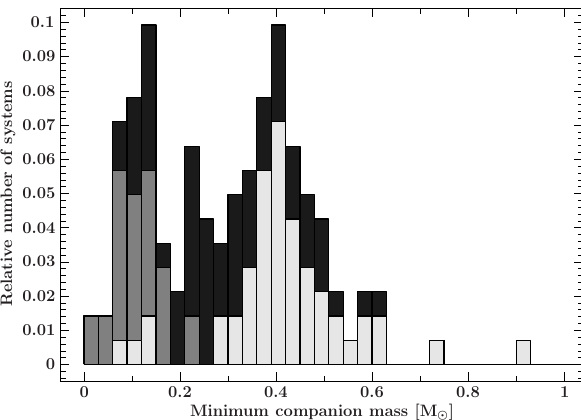
Figure 9. Companion mass histogram of the sample of sdB binaries with known orbits (Kupfer et al. 2015). Systems with white dwarf companions are depicted in light grey, those with M-dwarf compan- ions in grey, and systems for which the nature of the companion is unclear are marked in black. Adapted from Kupfer et al.